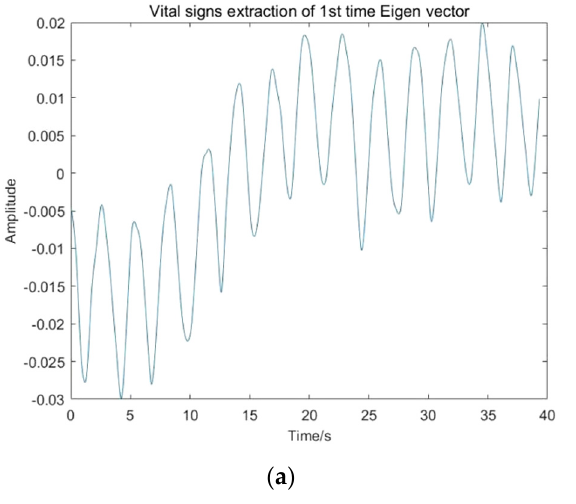
Figure 13. Frequency range of radar signal under wavelet multi-scale decomposition.